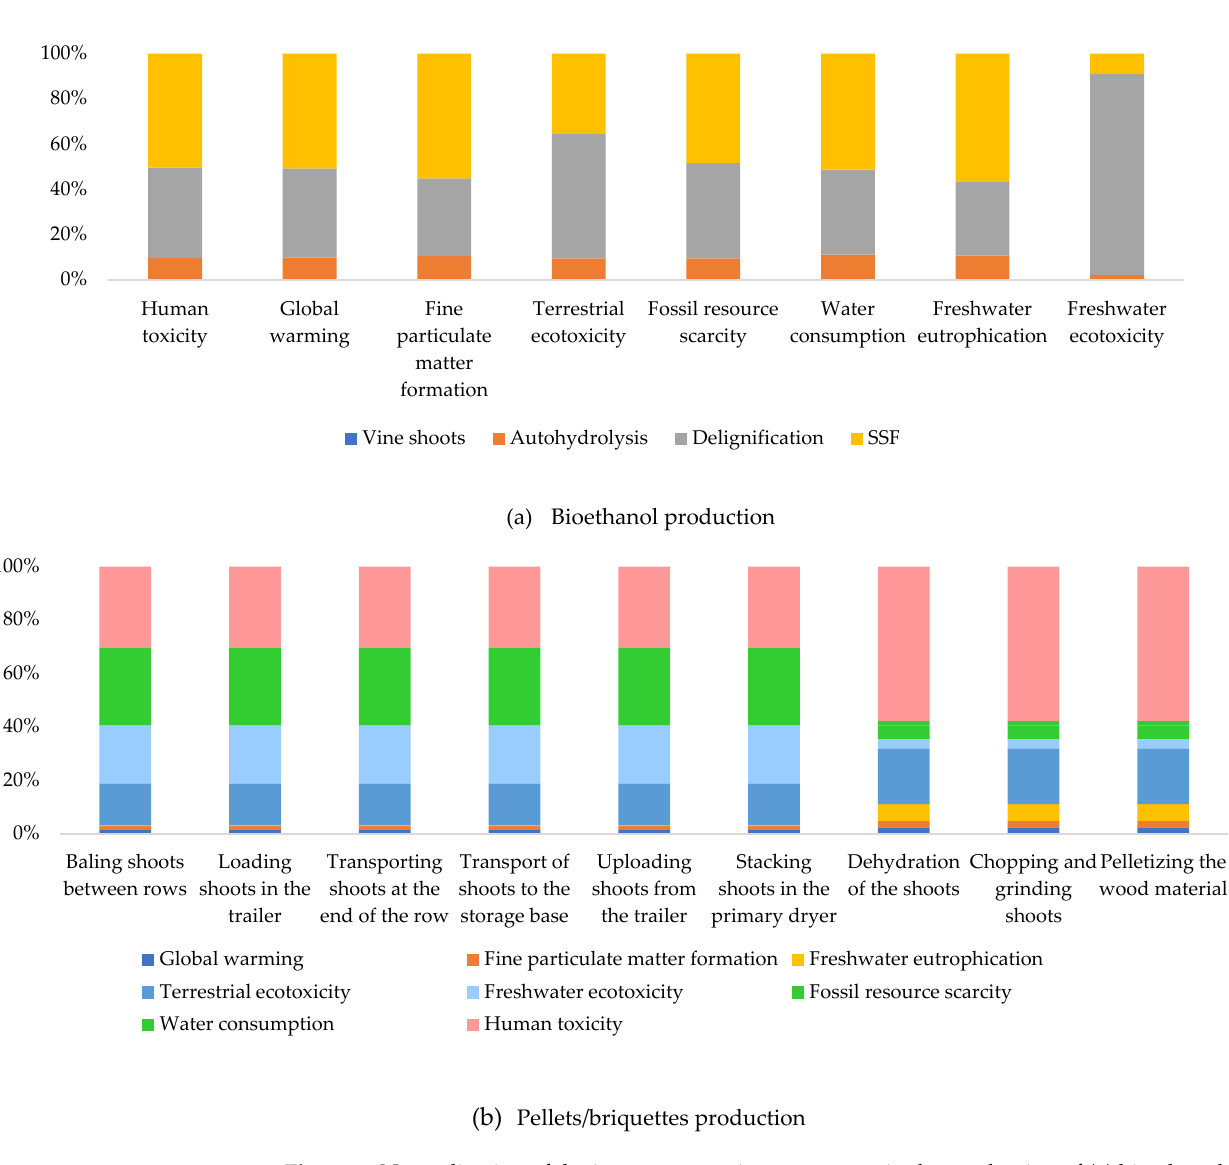
Figure 3. Normalization of the impact categories assessment in the production of ( a ) bioethanol and ( b ) pellets/briquettes.